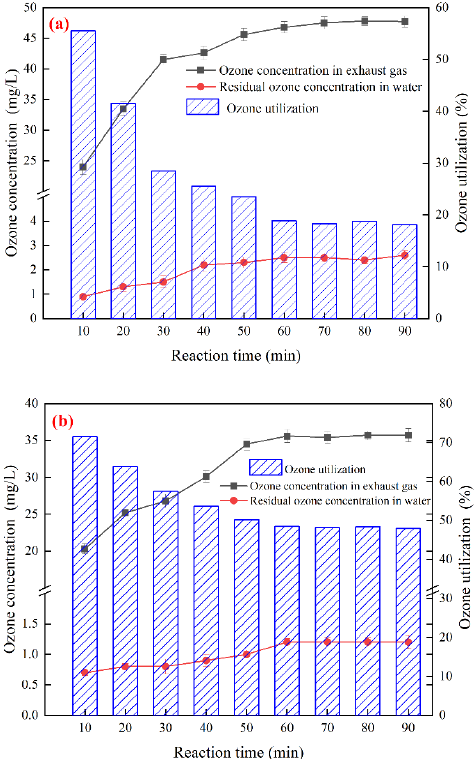
Figure 6. Ozone utilization rate: ( a ) ozone system, ( b ) catalytic ozone oxidation